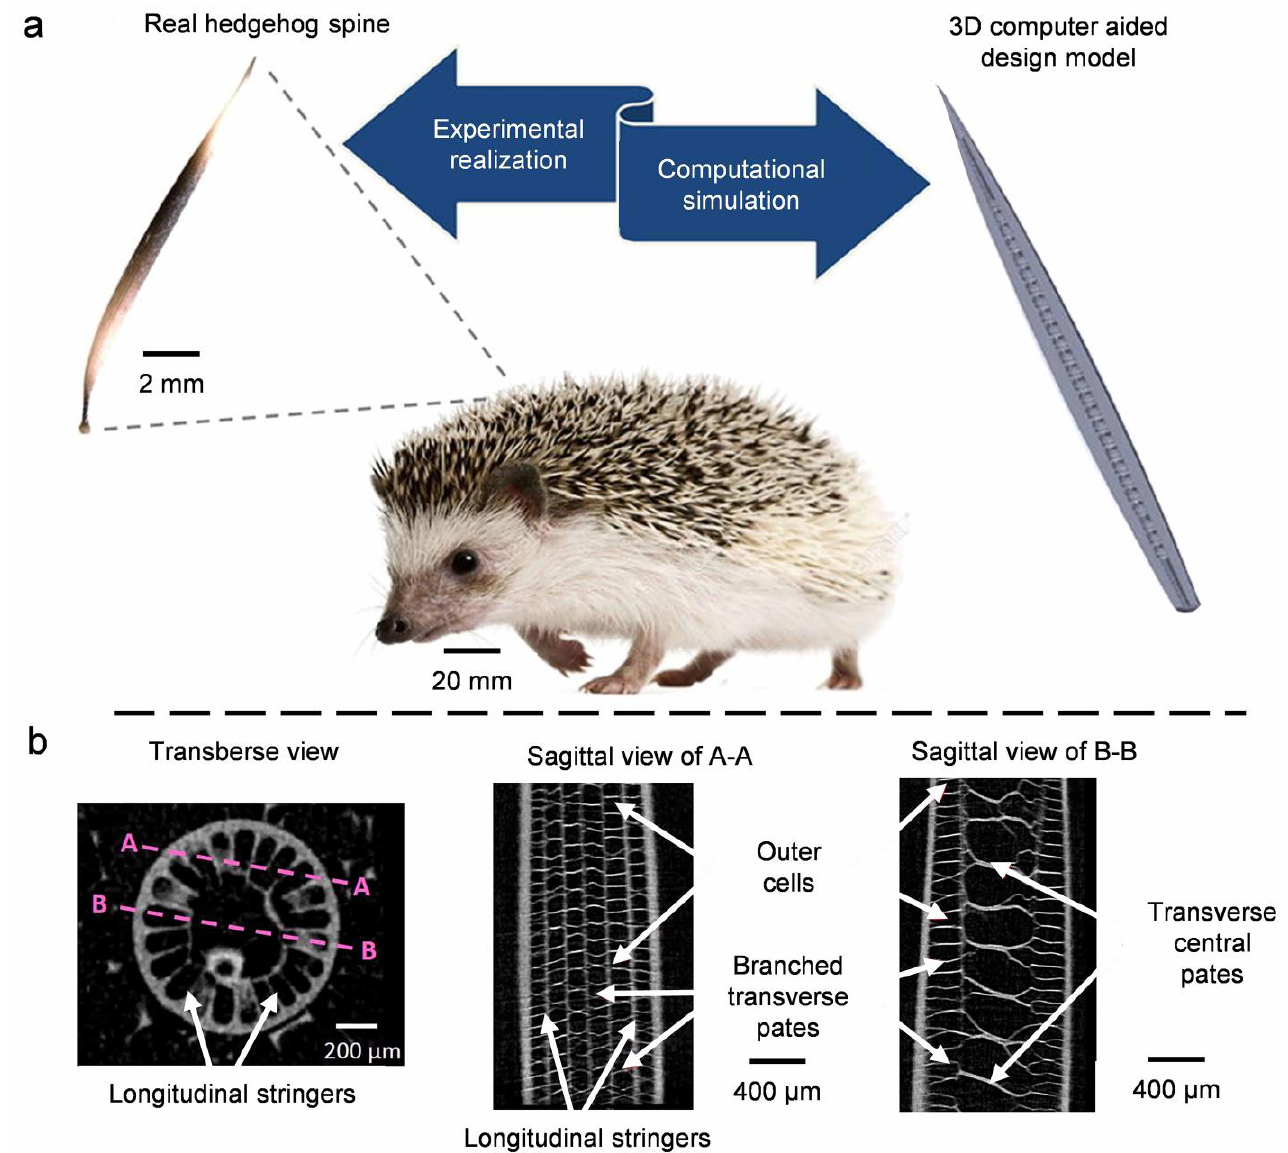
Figure 9. ( a ) Digital photographs and modeling of a single spine of a hedgehog. ( b ) X-ray micro-computed tomography images of key features in a hedgehog spine with different sections. Reprinted with permission from [41], copyright 2019 ELSEVIER SCI LTD.